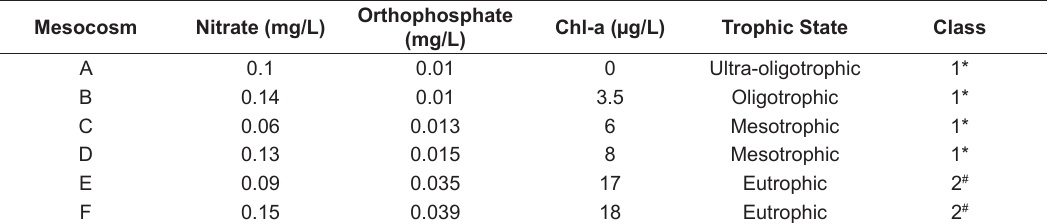
Table 2. Concentration of Nitrate, Orthophosphate, Chlorophyll-a (Chl-a), trophic state and water class of each mesocosms used in experiment. The columns water class indicates the classification of water bodies in accordance with Conama resolution 357, of March17, 2005 and its rectifications.